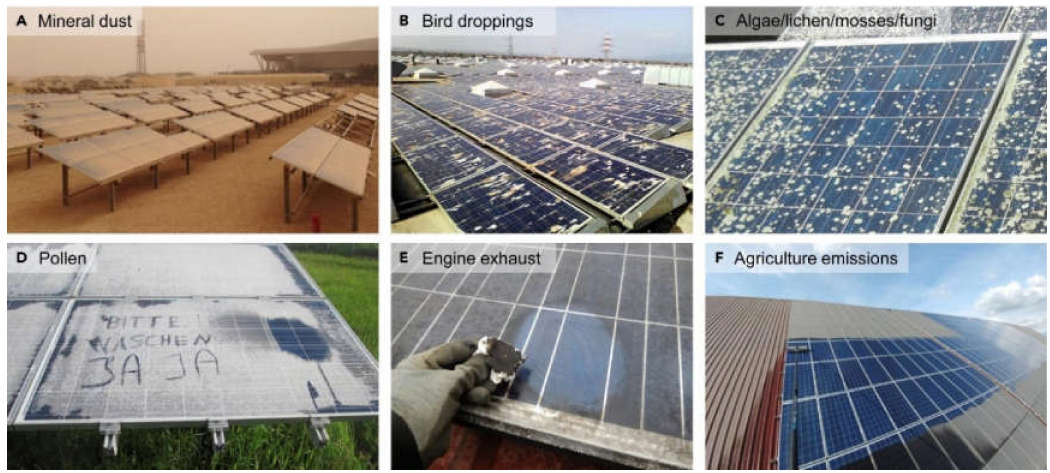
Figure 1. Examples of soiling. Overview of di ff erent soiling types with exemplary photographs of soiling by ( A ) mineral dust in a desert area, ( B ) bird droppings, ( C ) algae, lichen, mosses, or fungi, ( D ) pollen in wet and moderate climates, ( E ) engine exhaust from an industrial area, and ( F ) agricultural emissions. (taken from [39]).